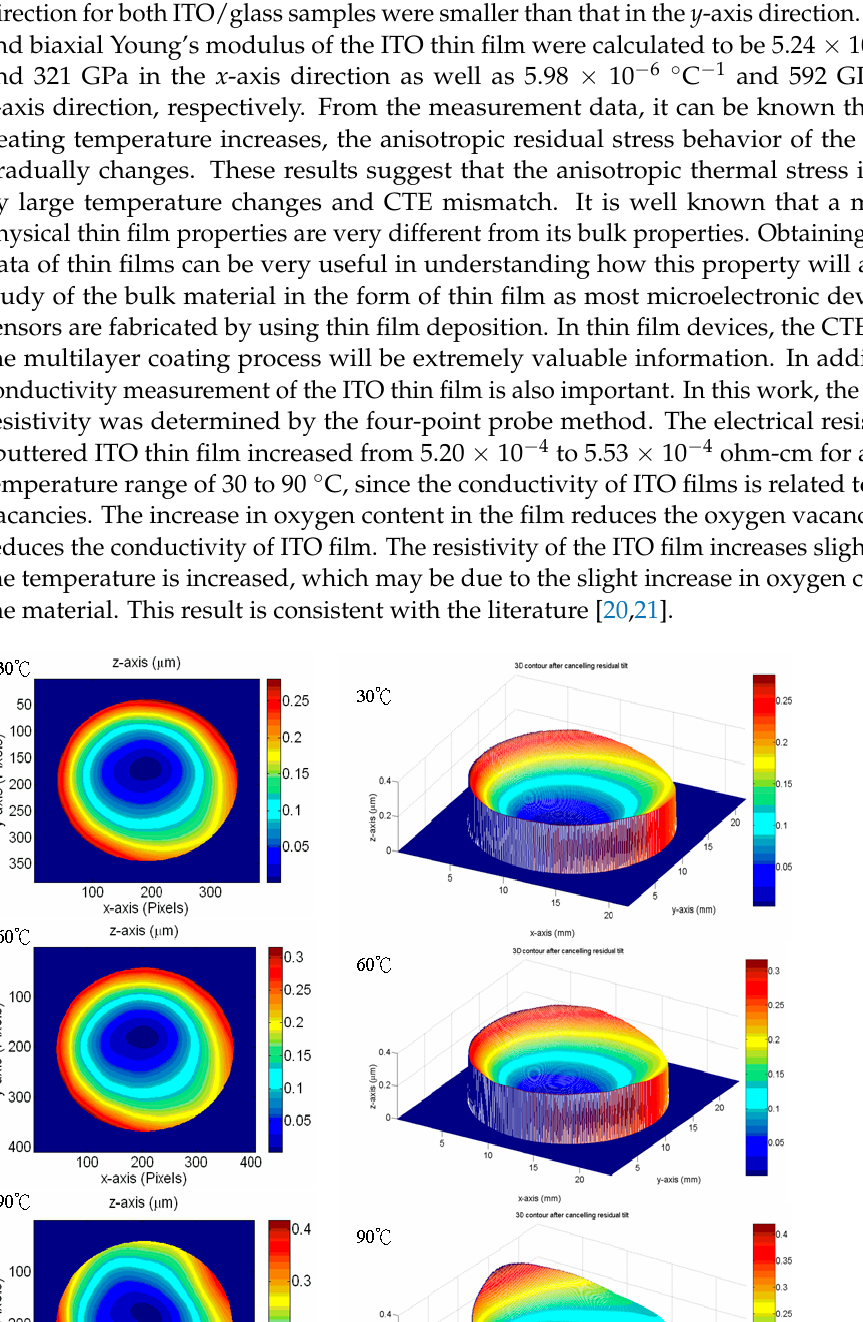
5.81 × 10 − 6 ◦ C − 1 and biaxial Young’s modulus of 475 GPa for the ITO thin film were obtained. Furthermore, the plot of thermal stress of the ITO films versus temperature in different axial directions was measured. The results show that thermal stress in the x -axis direction for both ITO/glass samples were smaller than that in the y -axis direction. The CTE and biaxial Young’s modulus of the ITO thin film were calculated to be 5.24 × 10 − 6 ◦ C − 1 and 321 GPa in the x -axis direction as well as 5.98 × 10 − 6 ◦ C − 1 and 592 GPa in the y -axis direction, respectively. From the measurement data, it can be known that as the heating temperature increases, the anisotropic residual stress behavior of the ITO film gradually changes. These results suggest that the anisotropic thermal stress is caused by large temperature changes and CTE mismatch. It is well known that a material’s